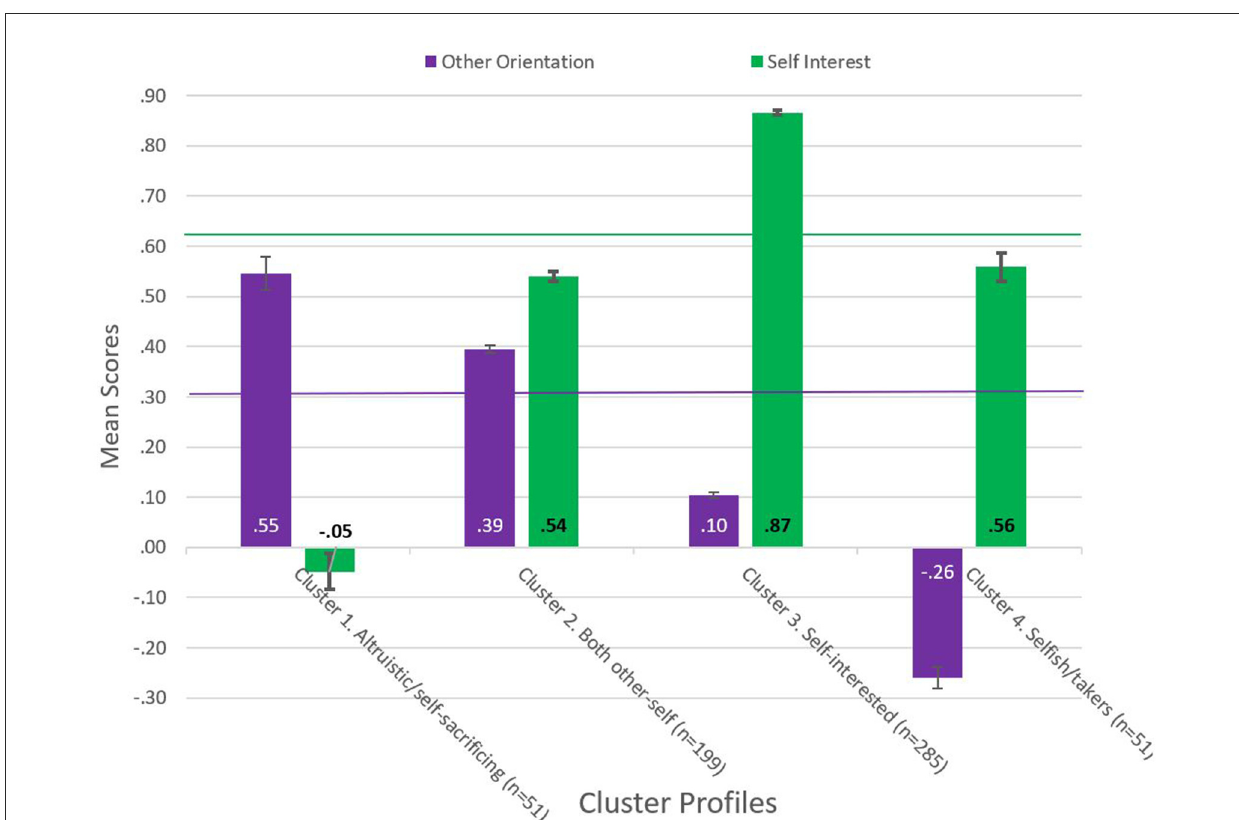
FIGURE3 Mean scores (s.e.) of other-orientation and self-interest to respondents in the four cluster profiles ( n = 586). Horizontal lines indicate the sample population mean for other-orientation ( u = 0.21) and self-interest ( u = 0.65).